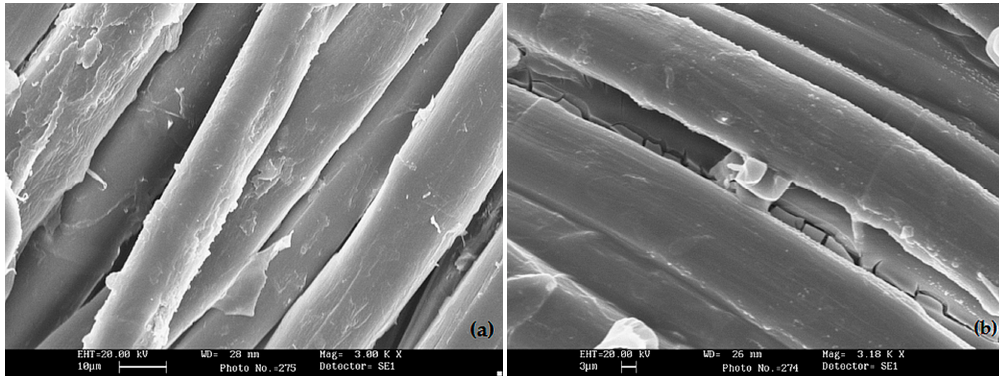
Figure 2. Scanning Electron Microscope (SEM) images of: ( a ) untreated hemp fabric (scale bar: 10 μ m); ( b ) hemp fabric after the waterglass treatment (scale bar: 3 μ m).